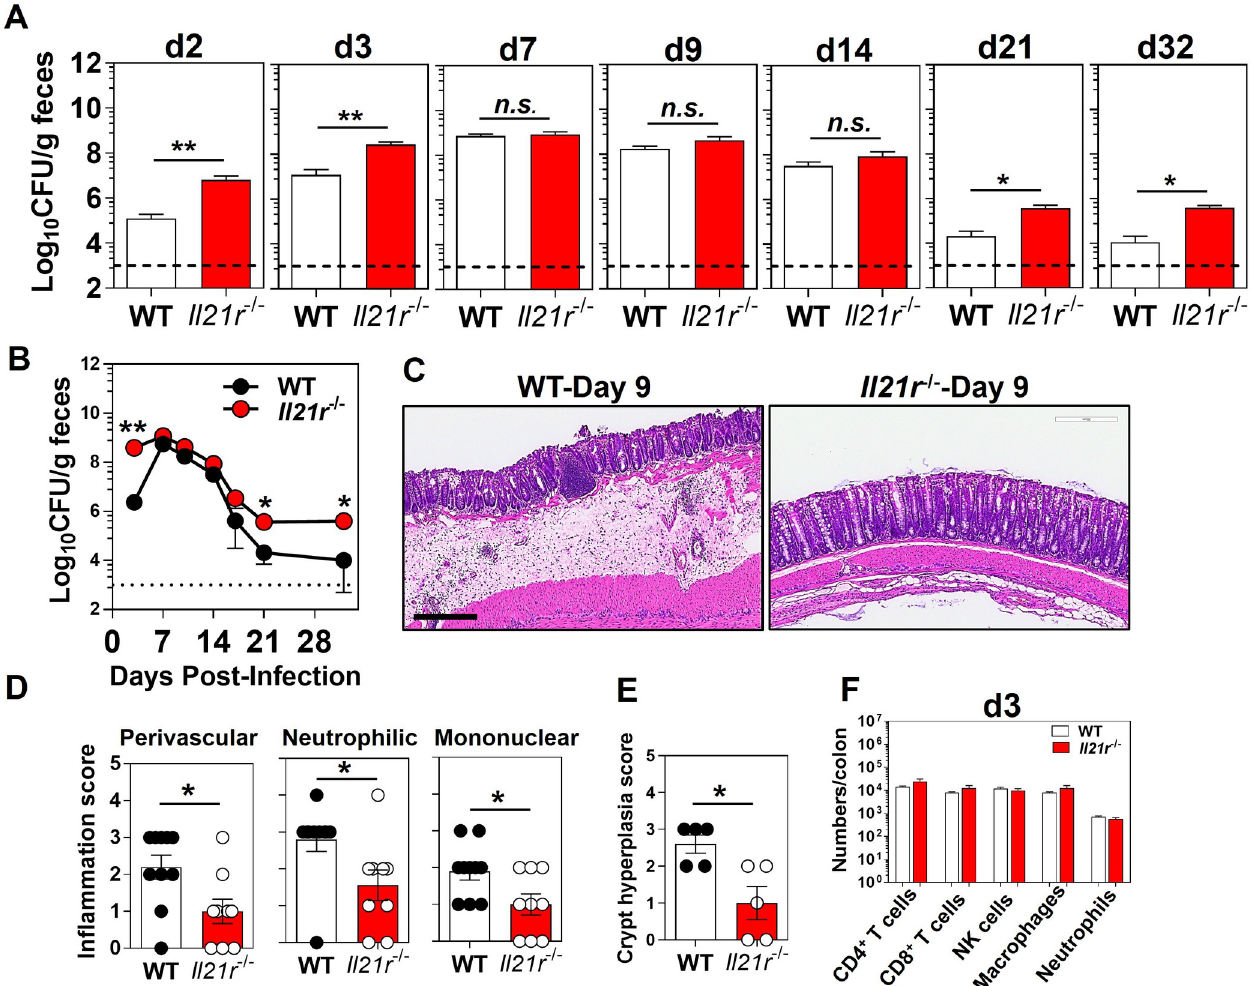
Fig 1. An intact IL-21/IL-21R signaling axis is required for host protection against colon Citrobacter rodentium infection. A . Bacterial burden and B . infection kinetics in the feces of Il21r -/- mice and WT controls shown as colony forming unit (CFU)/g feces. The results are the Mean ± SEM of 5–13 mice per group pooled from two of four independent experiments with similar results. The dashed line represents the sensitivity of the culture method. � p < 0.05; �� p < 0.001 determined by Mann-Whitney U test. C . Representative colonic pathology as assessed by hematoxylin and eosin (H&E) staining (5 × ). The scale bar, 300 μ m. D . Inflammation scoring of distal colon of Il21r -/- mice and WT controls at 9 days after infection with C . rodentium . Data are the Mean ± SEM from two pooled independent experiments with a total of 9 ( Il21r -/- ) or 10 (WT) mice/group. � p < 0.05 determined by Mann-Whitney U test. E . Histological scoring of crypt hyperplasia in distal colon of Il21r -/- mice and WT controls at 9 days after infection with C . rodentium . Data are representative of one of two independent experiments with a total of 5 ( Il21r -/- ) or 5 (WT) mice/group. � p < 0.05 determined by Mann-Whitney U test. F . The absolute numbers of immune subsets in the whole colon LP of Il21r -/- mice and WT controls at 3 days p.i. Data are the Mean ± SEM of absolute numbers of immune cell types, analyzed by Mann-Whitney U